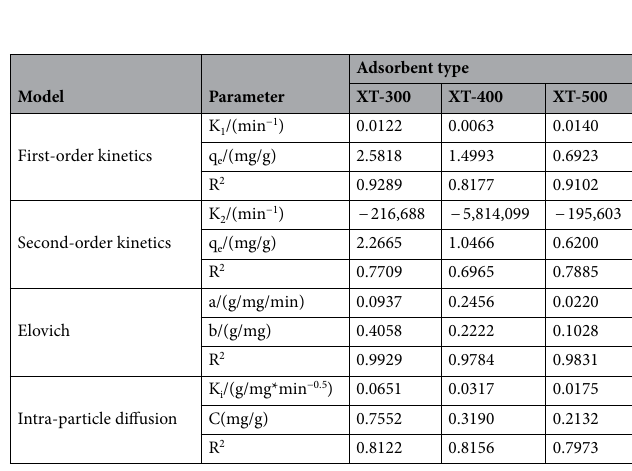
Table 3. Adsorption parameters of phosphorus adsorption kinetic model of adsorbents at different